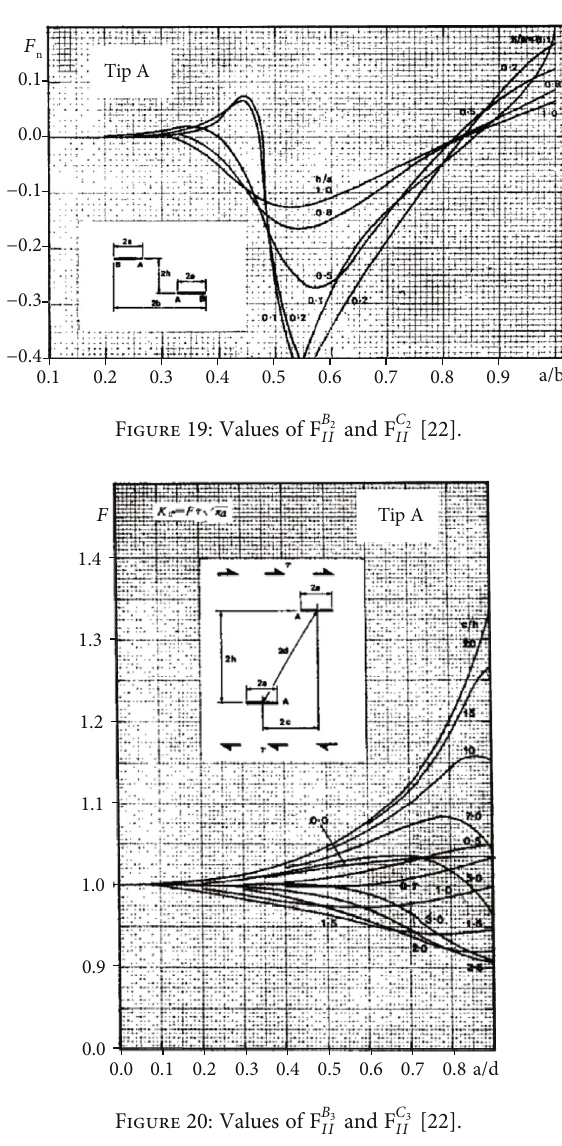
Figure 20: Values of F B 3